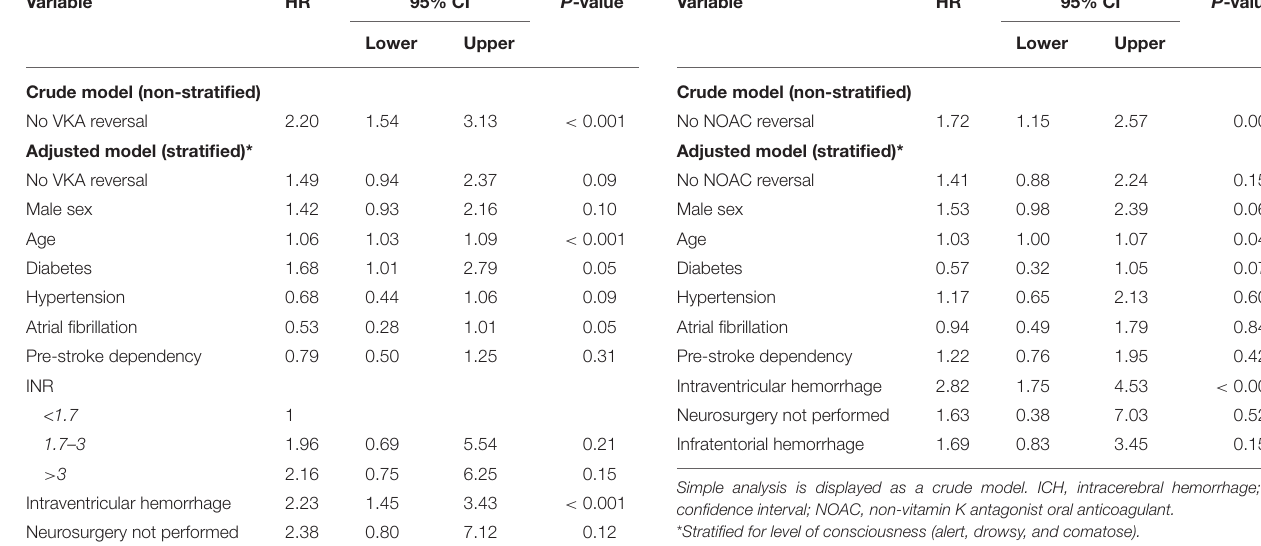
TABLE 3B | Cox regression analysis stratified for level of consciousness showing Hazard Ratios (HR) for 90-day mortality in 235 patients with NOAC-ICH. Variable HR 95%